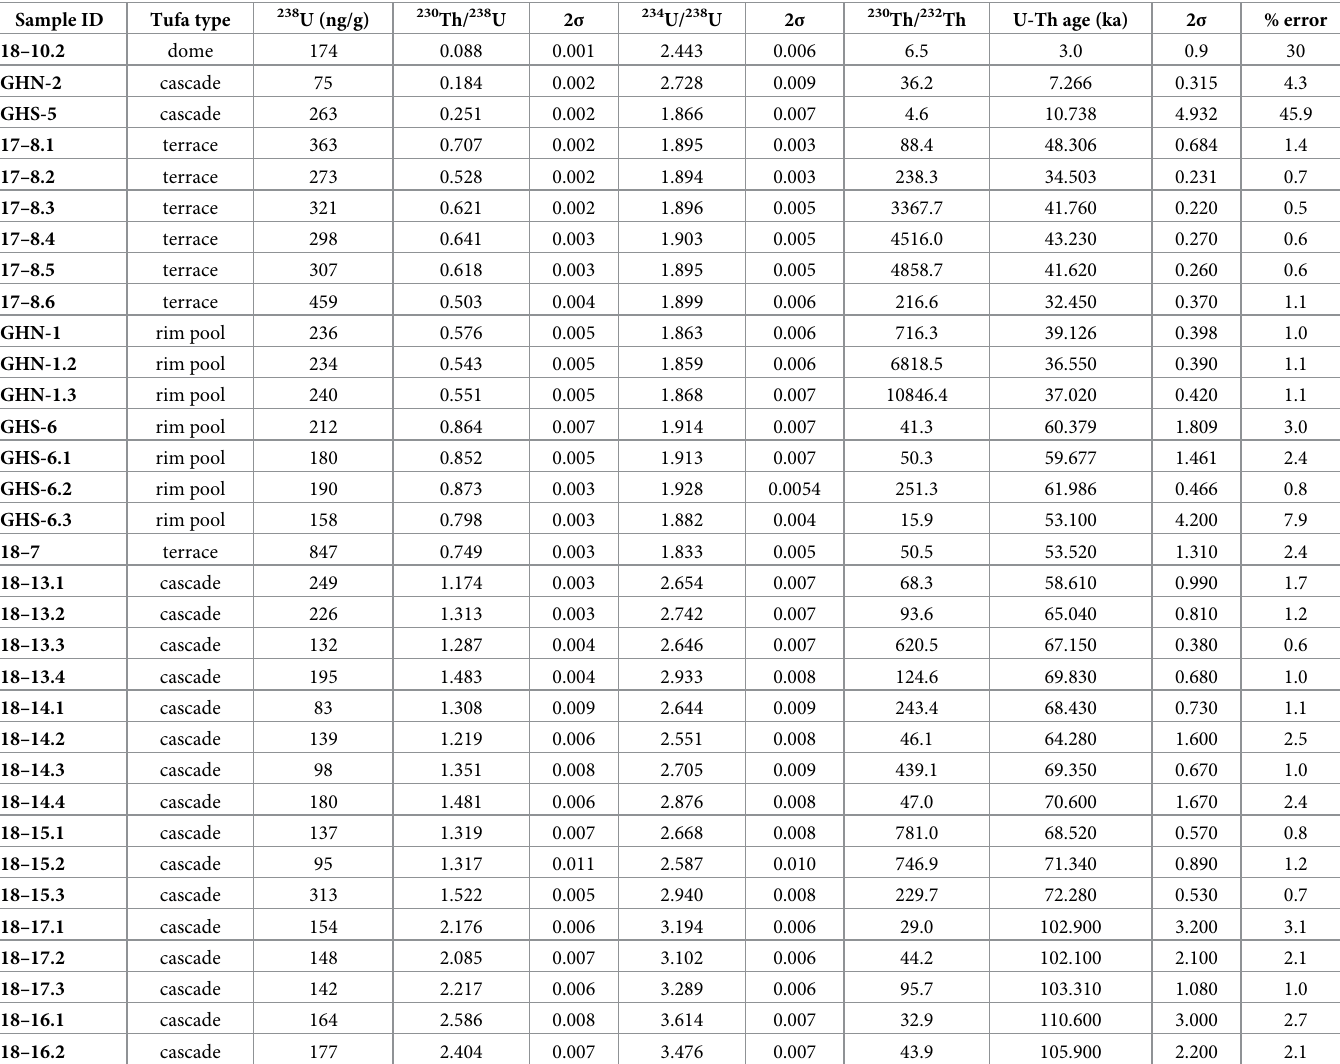
Table 1. U-Th age data for tufa samples from Ga-Mohana Hill. The samples are labelled according to the sequence they were collected in but presented in stratigraphic order. Errors on all isotope activity ratios are reported with 2 σ uncertainty. All ages have been corrected to account for the effect of detrital Th assuming an estimate for ini- tial 230 Th/ 232 Th of 1.5 ± 1.5, and calculated using the 230 Th- 238 U decay constants of Cheng et al. [54] and equation 1 from Hellstrom